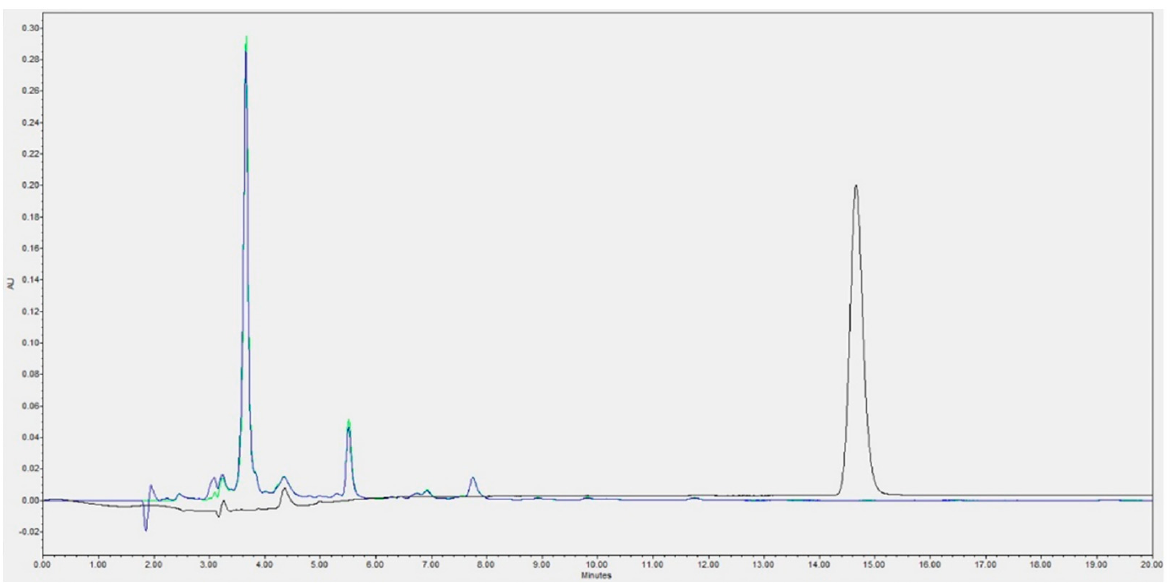
Figure 2. HPLC profile of the agave fructan bioconjugates with vinyl laurate at the beginning (black line) and at the end (green and blue lines) of the reaction.